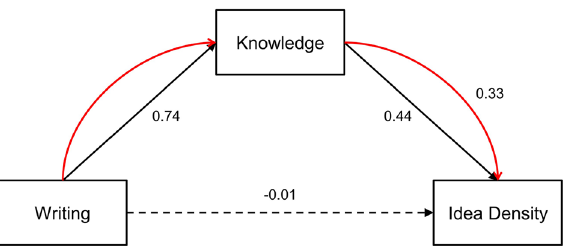
Figure 2. Illustration of the mediation model that includes writing accuracy of kanji abilities (predictor), knowledge acquisition (mediator), and idea density (outcome): Numbers on arrows indicate standardized regression coefficients. Black arrows represent the direct effects. Red arrows represent the indirect effects.